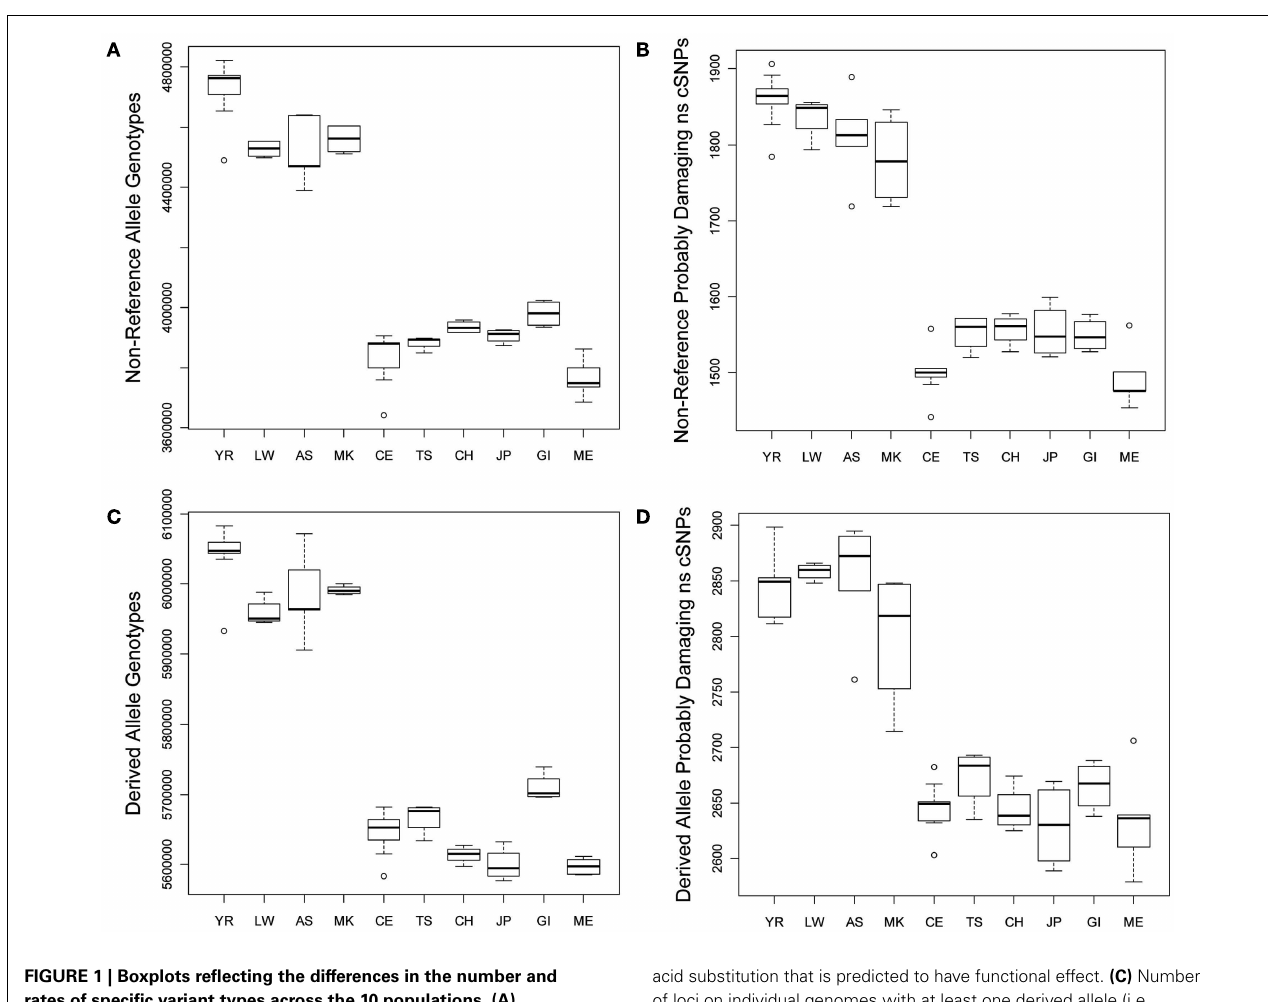
FIGURE 1 | Boxplots reflecting the differences in the number and rates of specific variant types across the 10 populations. (A) Number of loci on individual genomes with at least one non-reference allele (i.e., homozygous or heterozygous non-reference allele genotypes); (B) Number of coding loci on individual genomes with at least one non-reference allele that results in a non-synonymous amino